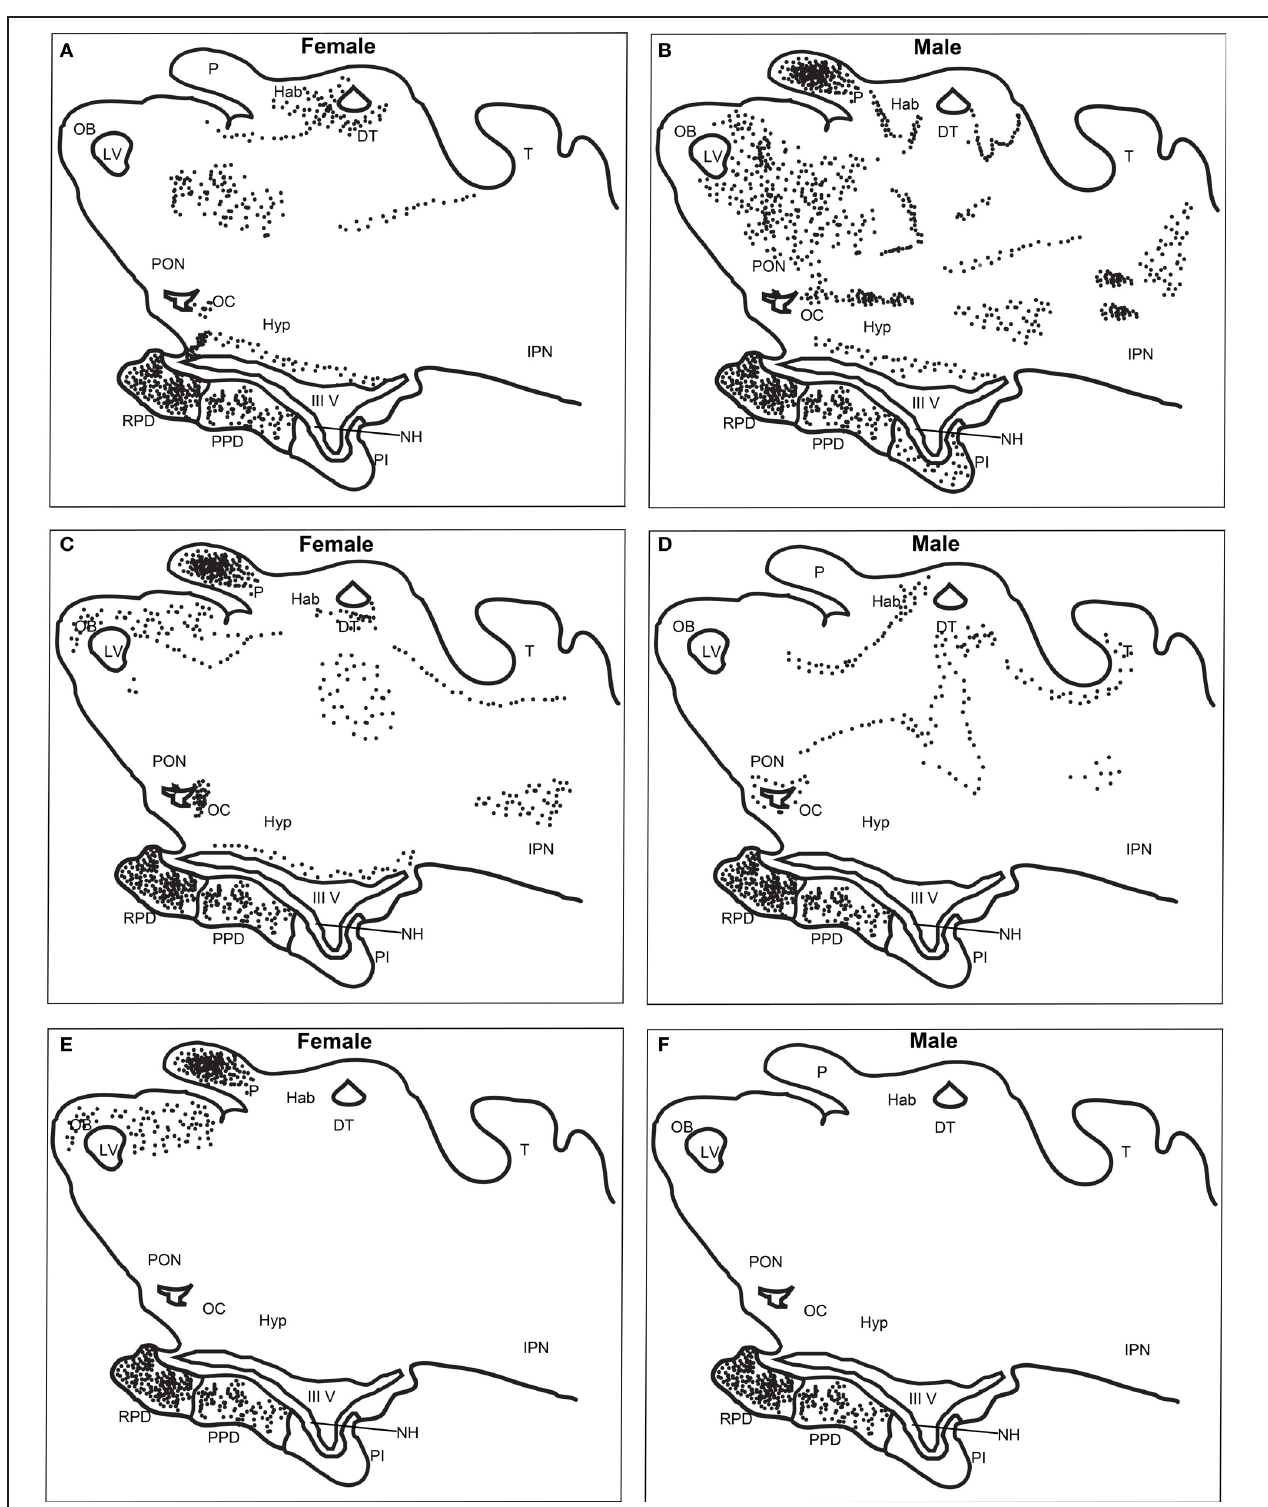
system. Key for labeled features; DT, Dorsal Thalamus; Hab, Habenula; Hyp, Hypothalamus; IPN, Interpeduncular Nucleus; IIIV, Third Ventricle; LV, Left Ventricle; NH, Neurohypophysis; OB, Olfactory Bulb; OC, Optic Chiasm; P, Pineal; PON, Preoptic Nucleus; PI, Pars Intermedia; PPD, Proximal Pars Distalis; RPD, Rostral Pars Distalis; and T, Optic